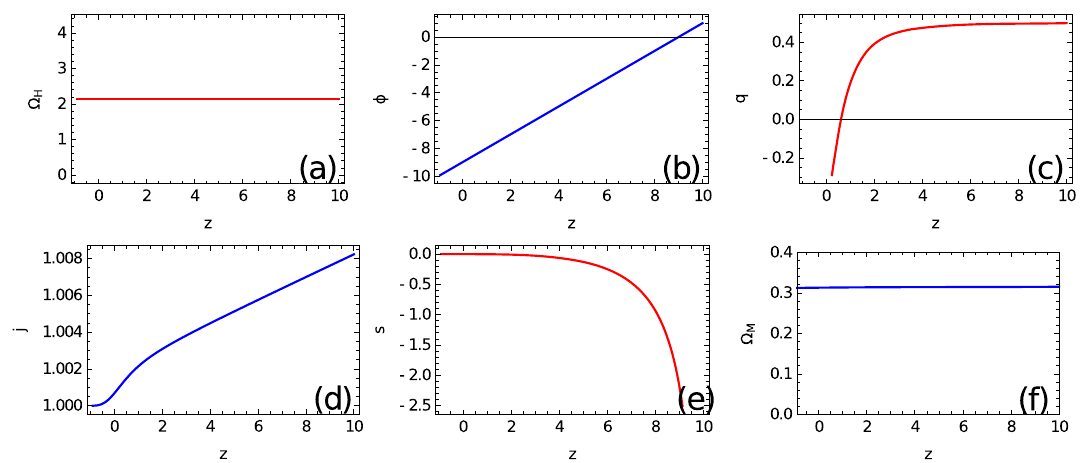
Fig. 1 Solutionsforthestatefinderparameter Ω H andscalarfield φ overreducedPlanckmasswithinteractionconsidering α = 0 . 9and β = 0 . 0004 in presence of a scalar field V (φ) . Cosmological parameters are also plotted as functions of redshift z